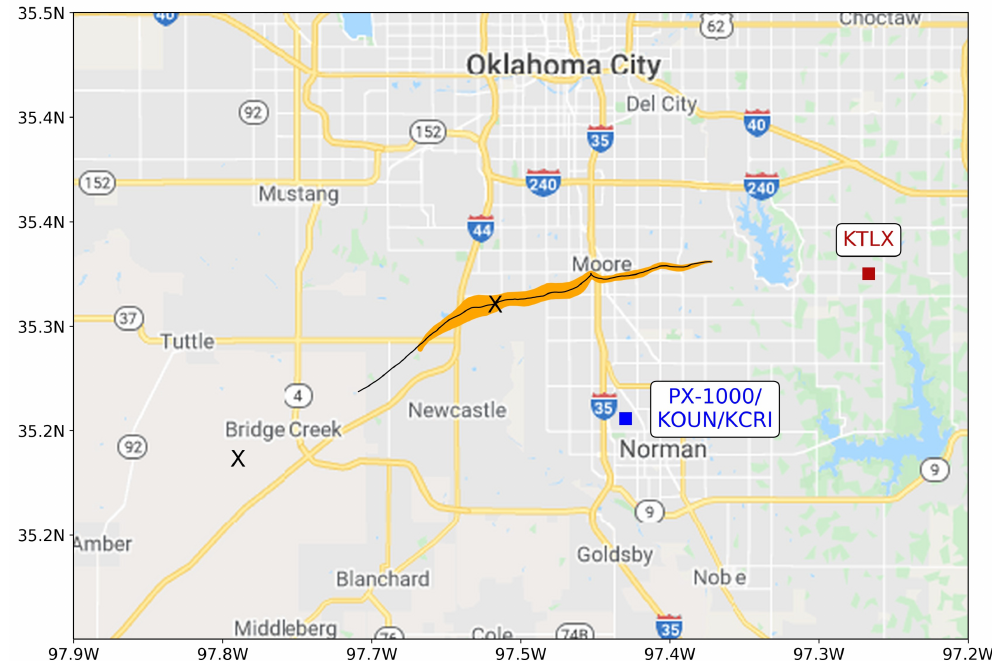
Figure 1. Map of the Oklahoma City, Oklahoma, U.S. metropolitan area overlaid with the National Weather Service Norman damage survey center track (black line) and EF-scale damage path (or- ange shading), with the “X”s denoting the start and end of the analysis period (1930–2008 UTC). The locations of the University of Oklahoma Advanced Radar Research Center’s PX-1000 (Norman, Oklahoma, U.S.) and National Oceanic and Atmospheric Administration’s (Norman, Oklahoma,